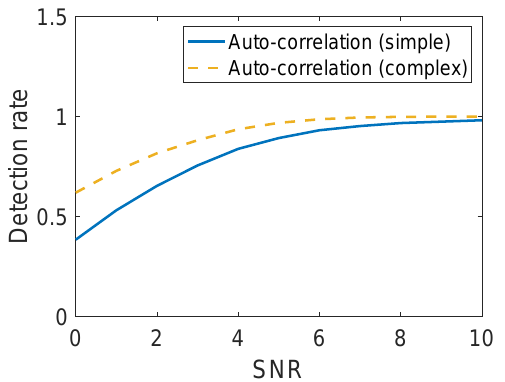
Figure 15. Complex decision rule for auto-correlation.